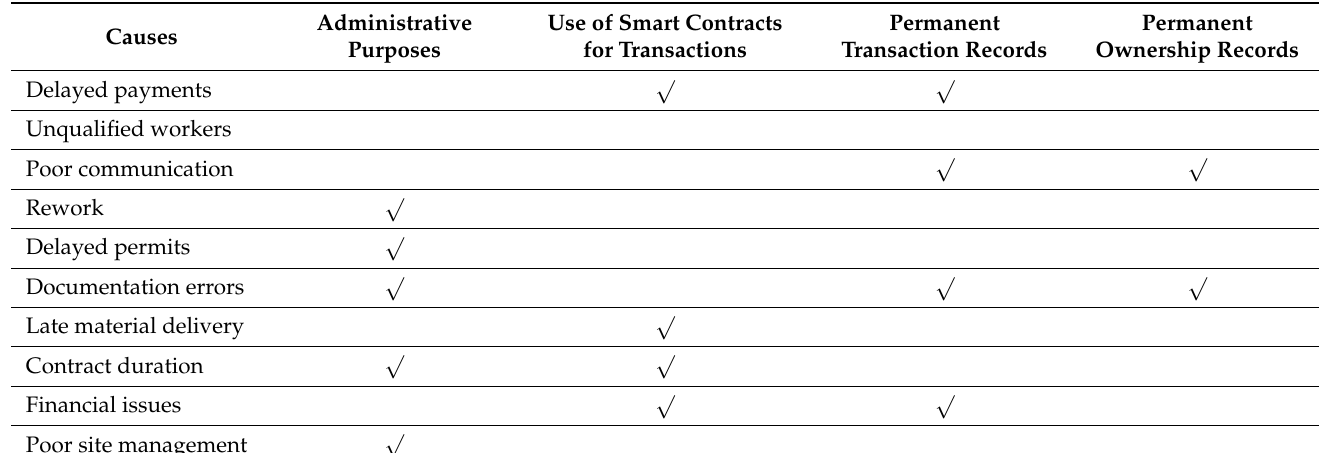
Table 5. Matched BCT use cases with identified causes of disputes and